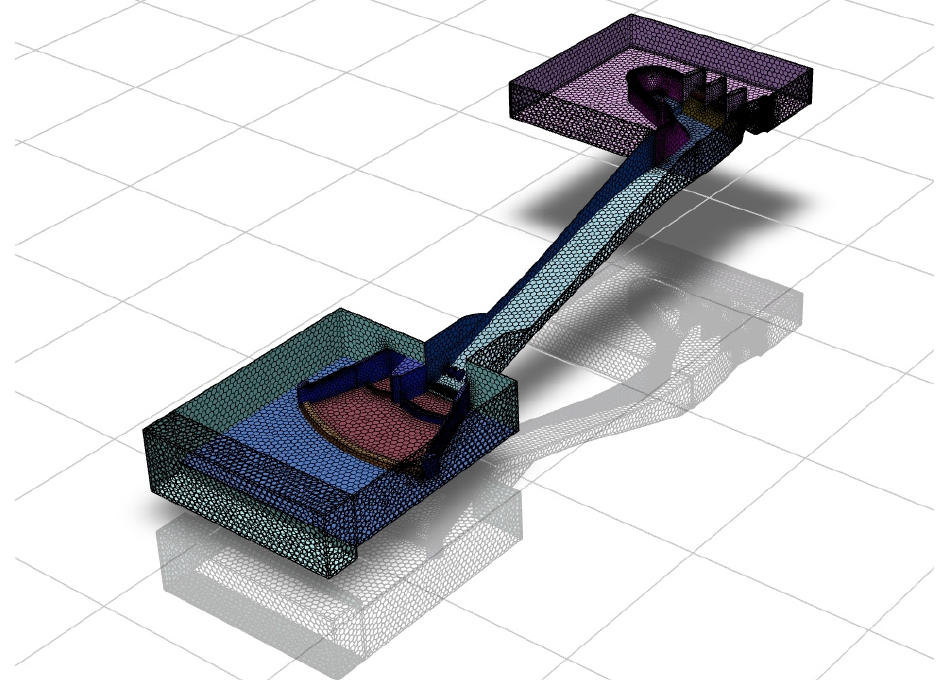
Figure 8. Computational domain for Model #2. Velocity values measured with a Pitot tube were used to validate the numerical models (Figure 9).